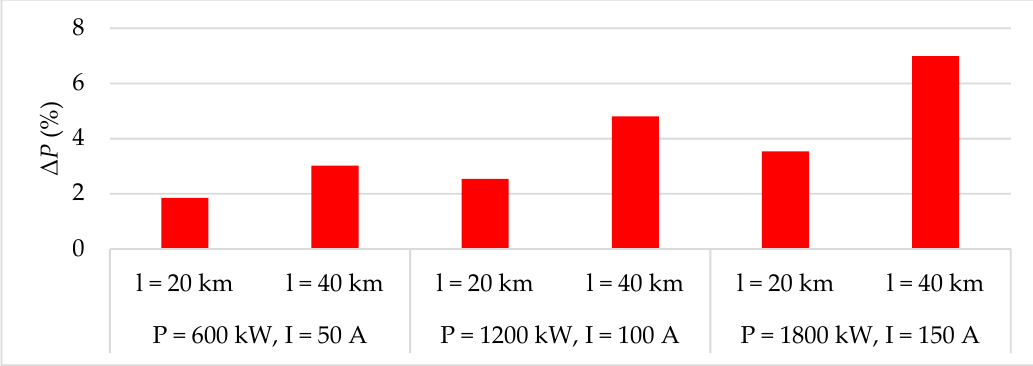
Figure 26. The comparison of the APLs for three types of active powers for conductor ACSR 95/15.